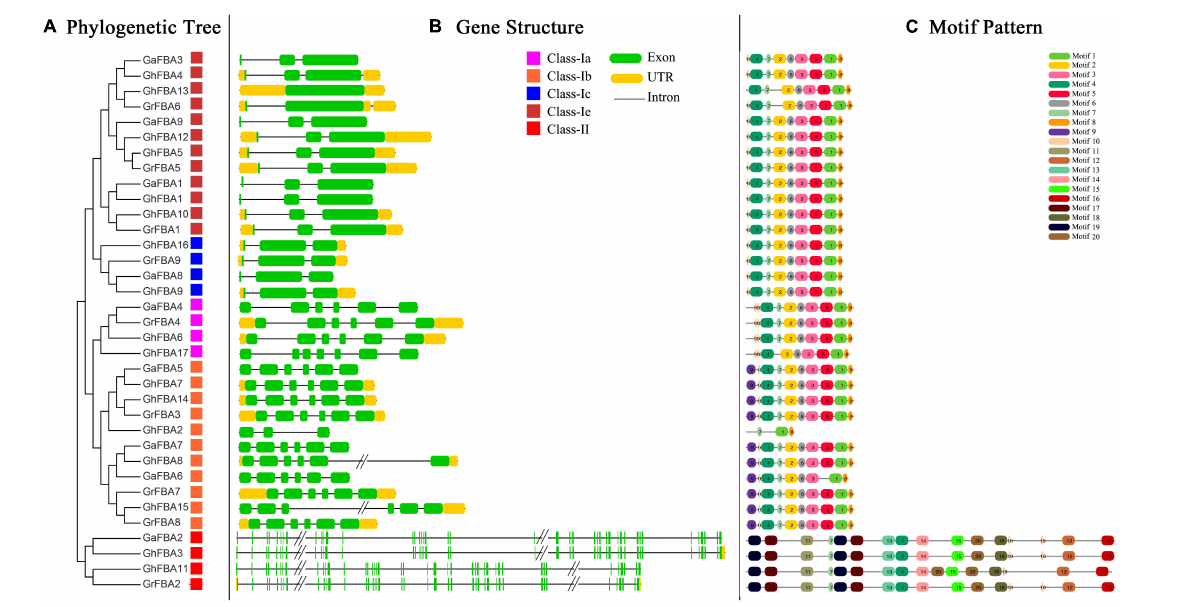
Frontiers in Plant Science |